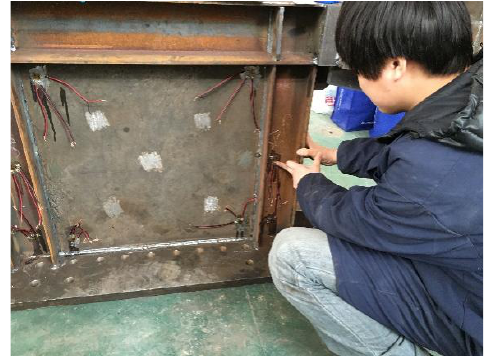
Figure 19. Strain gauge arrangement in specimen 1. Table 5. Strain values at different locations for specimen 1 at each level of peak load(units: με ). Infill Panel Left Column Levels Upper Right Lower Left Lower Right Middle Middle of Web